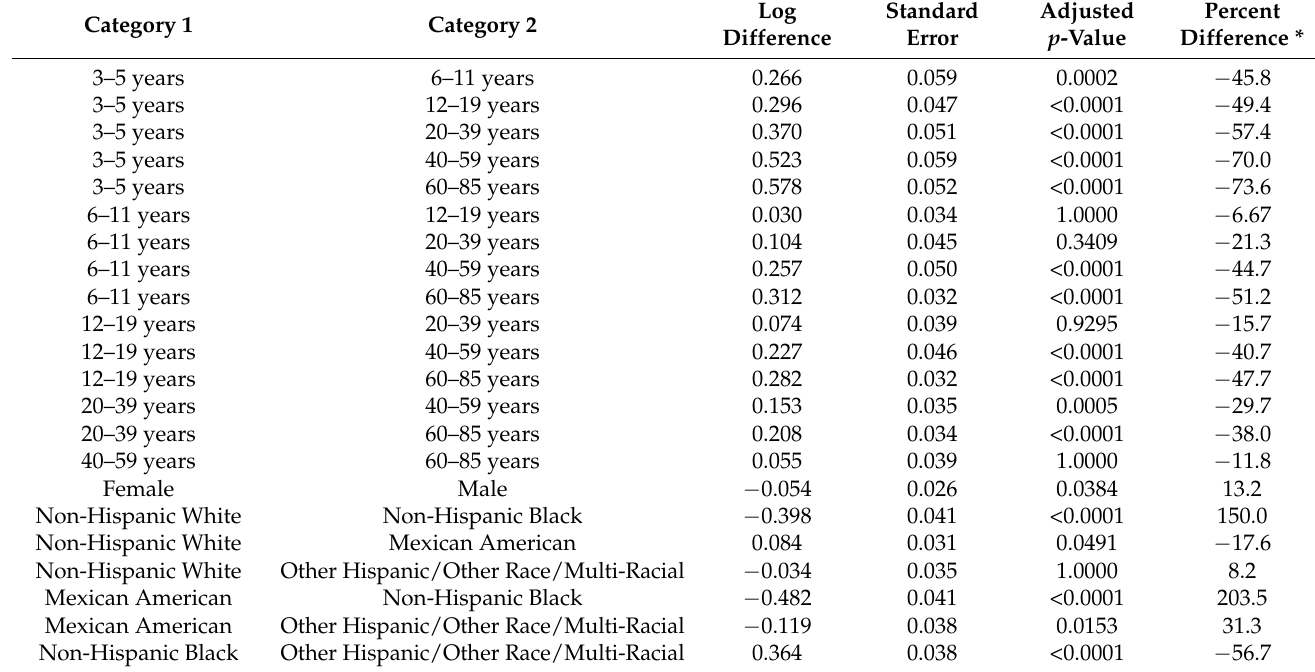
Table 2. Pairwise comparisons of sample-weighted serum cotinine geometric means (GM) between different demographic subgroups during the 2017–2018 NHANES survey period.